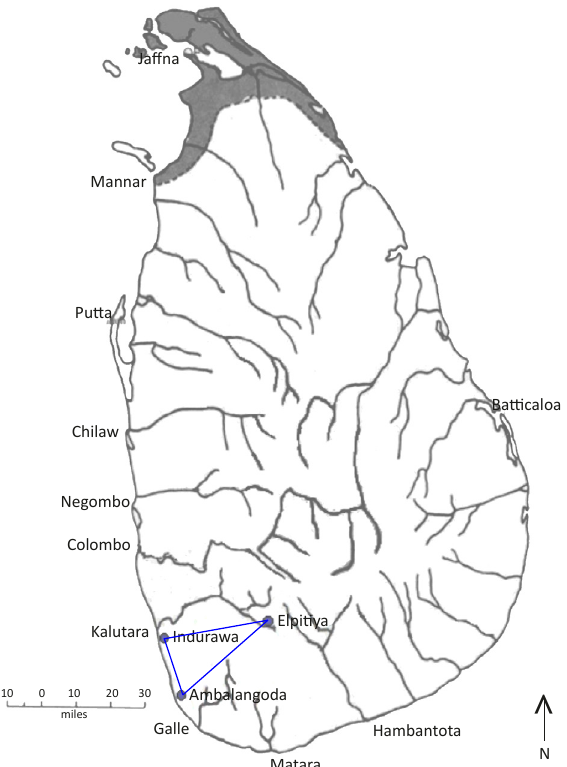
Figure 1. Sri Lanka showing main rivers of the island and distributions range of Hyelaphus procinus in 1994 (source: McCarthy & Dissanayaka